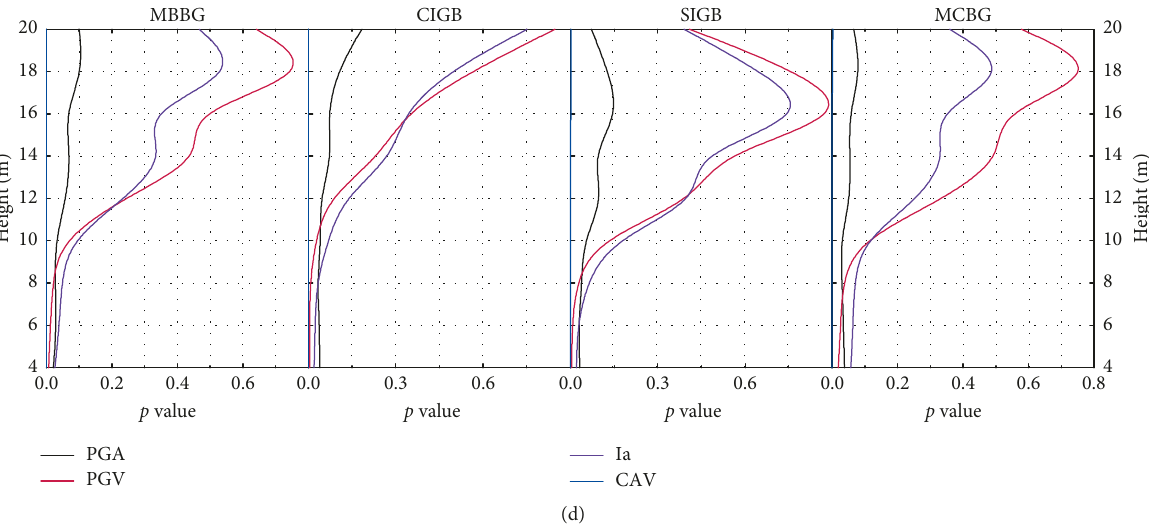
Figure 18: IMs sufficiency comparison with respect to R for (a) the pier curvature ductility along the longitudinal direction, (b) the pier curvature ductility along the transverse direction, (c) the bearing deformation along the longitudinal direction, and (d) the bearing deformation along the transverse direction. Table 8: Demand models and sufficiency comparison using p values of IMs subjected to far-field ground motions. Height